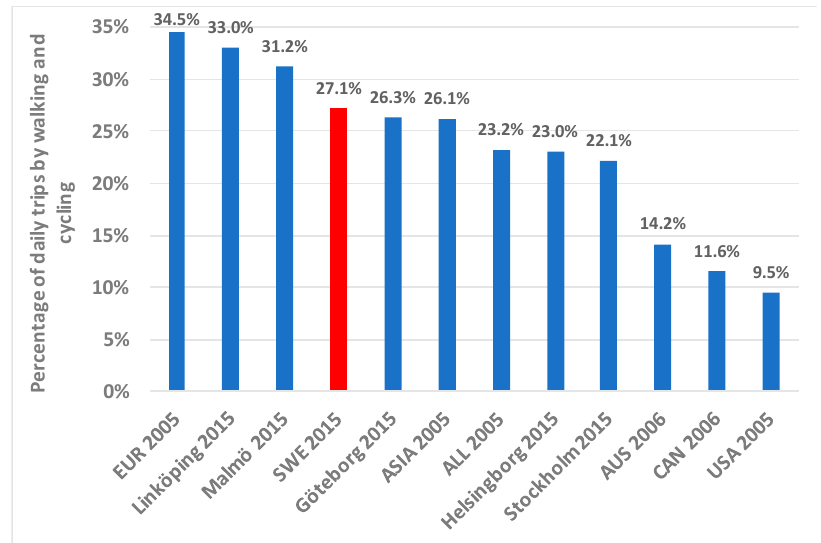
Figure 11. Percentage of daily trips by non-motorised modes in five Swedish cities (2015) compared to a sample of global cities (2005–2006).